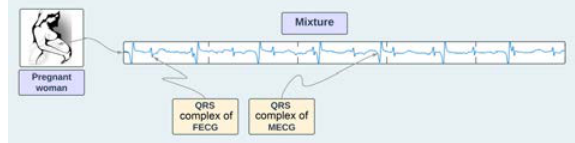
Fig. 4 Representation of global